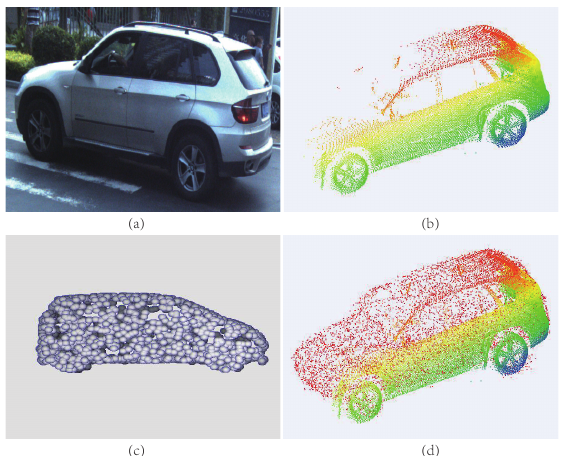
Figure 2. The sample images of reconstruction and completion on Mobile Laser Scanning (MLS) point clouds. ( a ) The real street images. ( b ) The scanned point clouds. ( c ) The generated point clouds (rendered). ( d ) The merged point